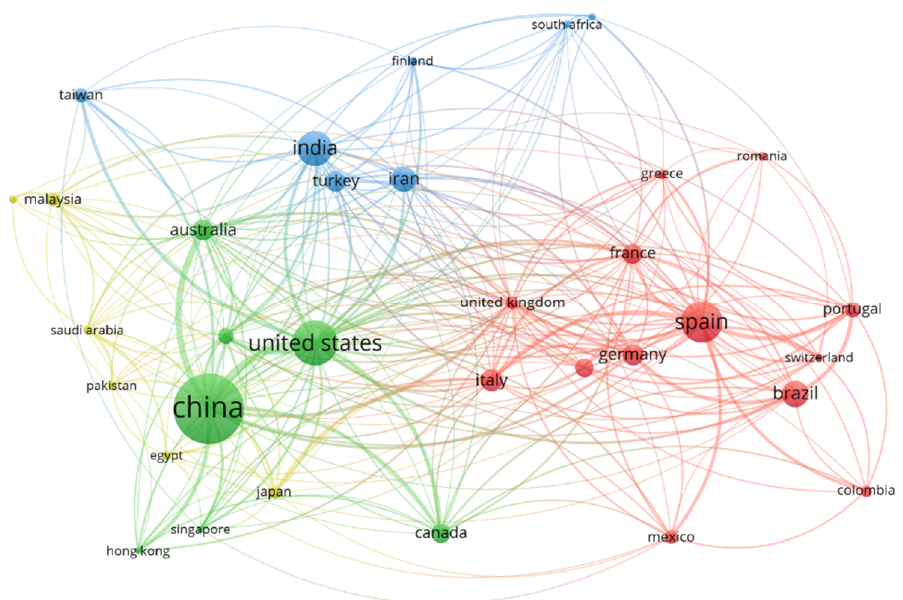
Figure 2. Bibliometric map of global collaboration network among countries between 1990 and 2021. Source: VOSviewer ® software.